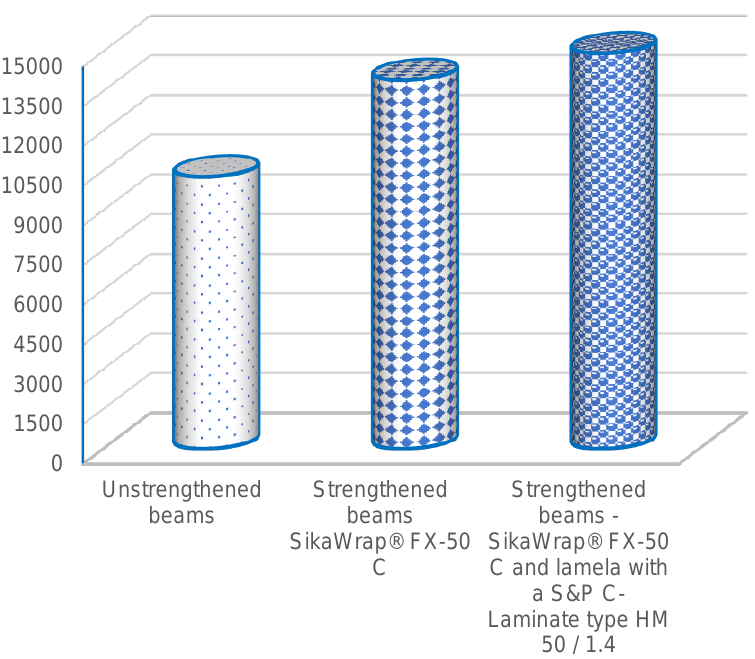
Figure 3. Load-displacement diagrams of FRP-strengthened and unstrengthened beams.